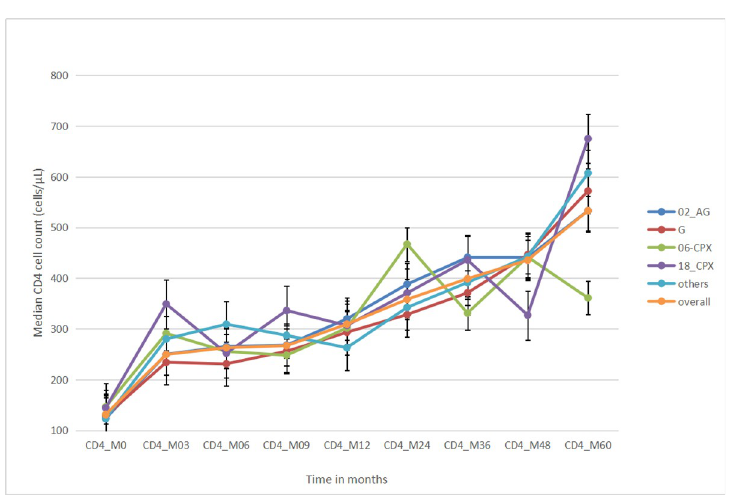
Fig 1. Median CD4+ cell count rise over time across